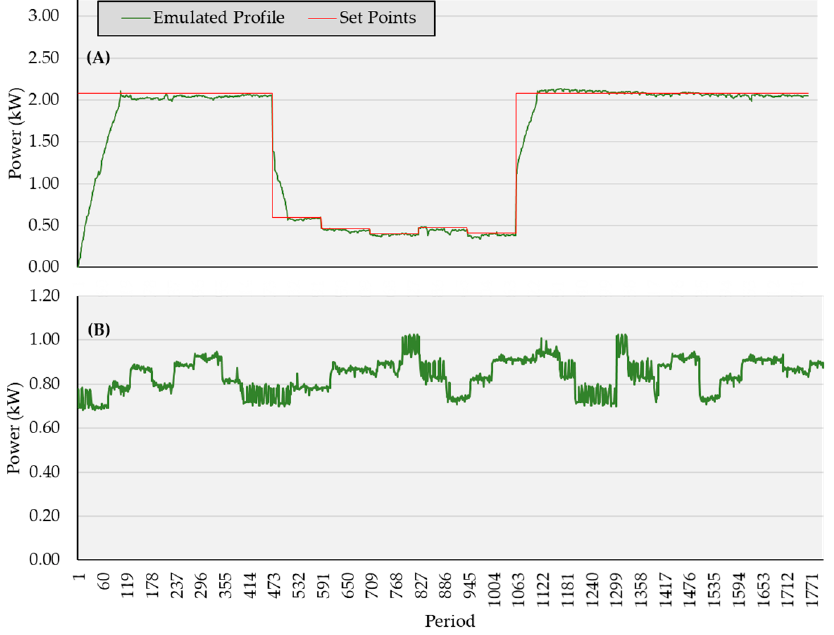
Figure 6. Experimental results adapted from emulators: ( A ) synchronous generator and ( B ) wind turbine emulator.